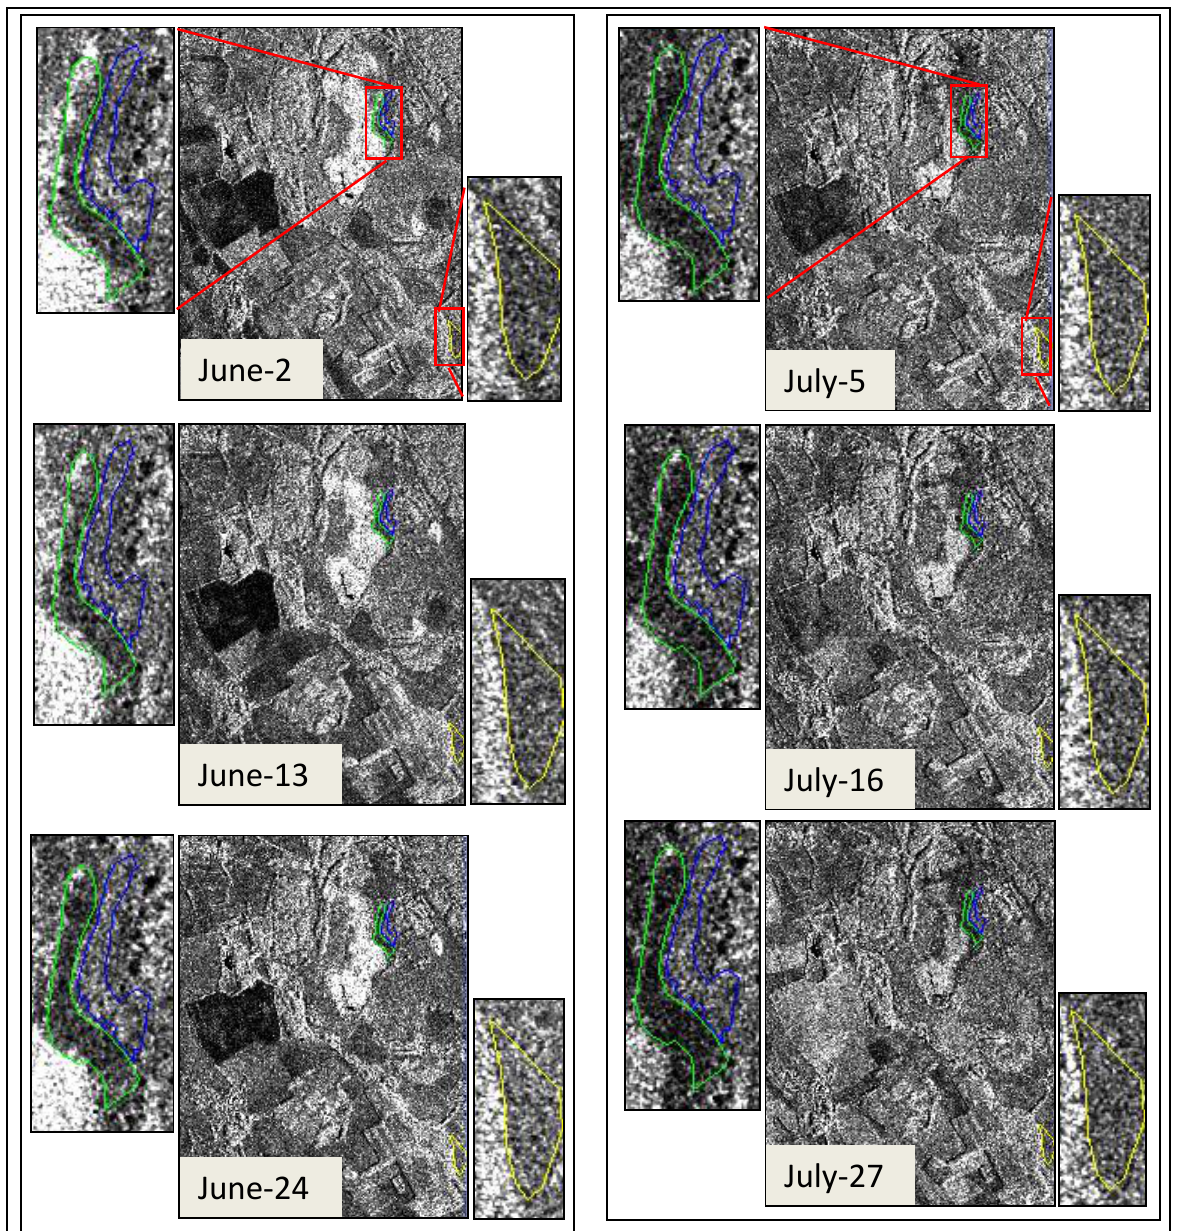
Figure 3. Comparison of the TerraSAR-X image segments in gray scale (the lighter the shading, the higher the backscatter signal) with special focus on the investigated areas: NATURA 2000 habitats 6410 (green), 6510 (yellow) as well as Pasture 1 ( blue) and the scene subset for comparison. Sites indicate swath effects by a distinctly lighter gray color: 29 August for meadow 6410; 24 June and 9 September for meadow 6510. The pasture site is not affected by